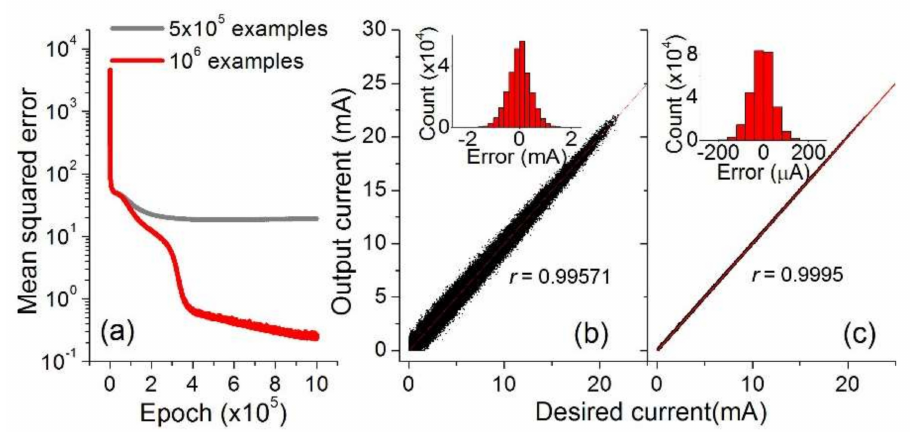
Figure 3. ( a ) Training the network (2,500 units in each of two hidden layers) with 500,000 and 1,000,000 examples for Type B switch. The capability of response inference is shown for the network trained with ( b ) 500,000 and ( c ) 1,000,000 examples. The insets address the distribution of inference-error.